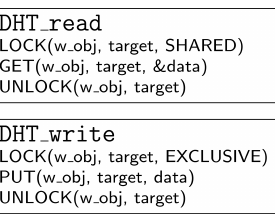
Figure 6. Readers-and-writers semantics for concurrent accesses (Christgau and Schnor, 2017).